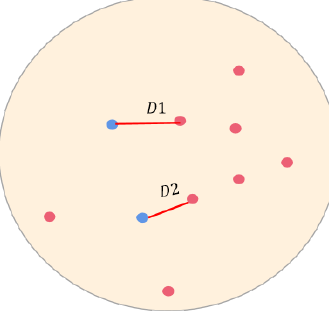
Figure 2. Diagram of the nearest crime distance: blue dots represent isolation locations, red dots are violent crime points, and D indicates the nearest distance to a crime from an isolation location.